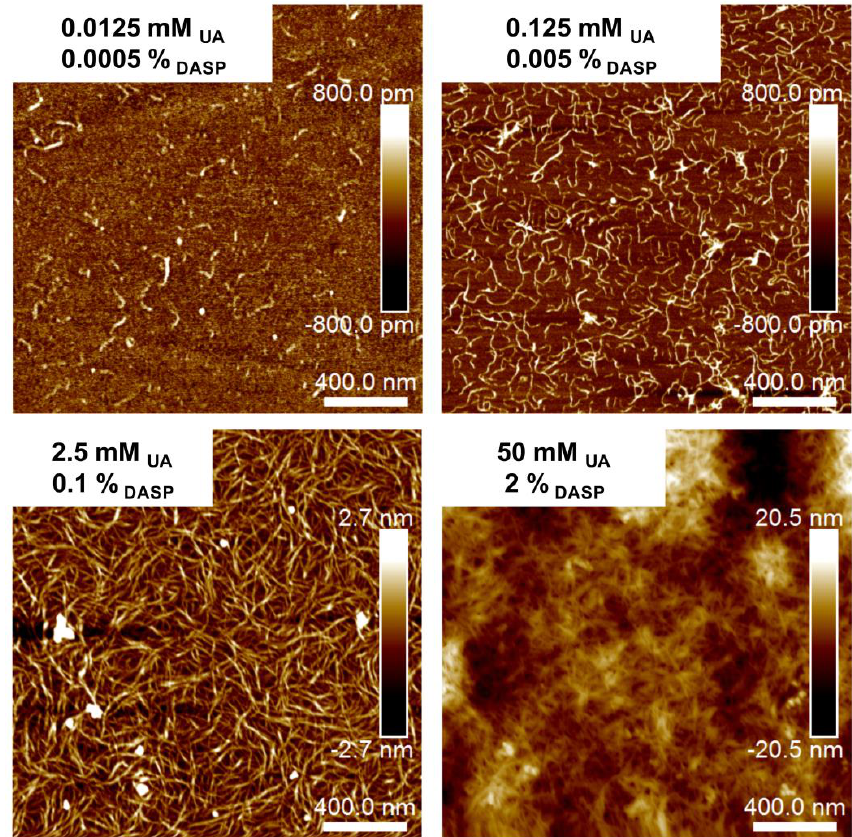
Figure 1. The atomic force microscopy (AFM) height images of 0.0005%, 0.005%, 0.1% and 2% sodium carbonate-soluble pectin (DASP) fraction samples and corresponding uronic acids (UA) concentration. Table 1. The surface roughness parameters of AFM images—average roughness (S a ) and root mean square roughness (S q ). The minimum and maximum values of these parameters are given.